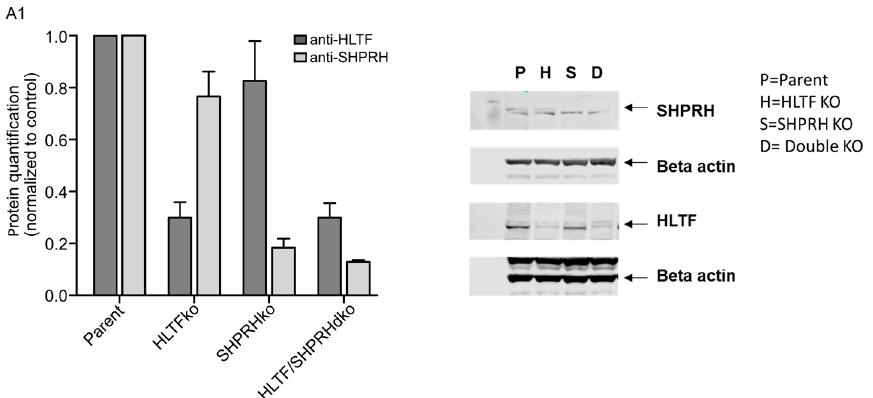
Figure A1. Hap1 knockout verification. Protein quantification by Western blot analysis (n = 3) (left). One representative western blot of Hap1 knockout cell lines shown (right). Arrow indicates protein of interest, SHPRH upper band, HLTF main/lower band. Related to Figure 1 .